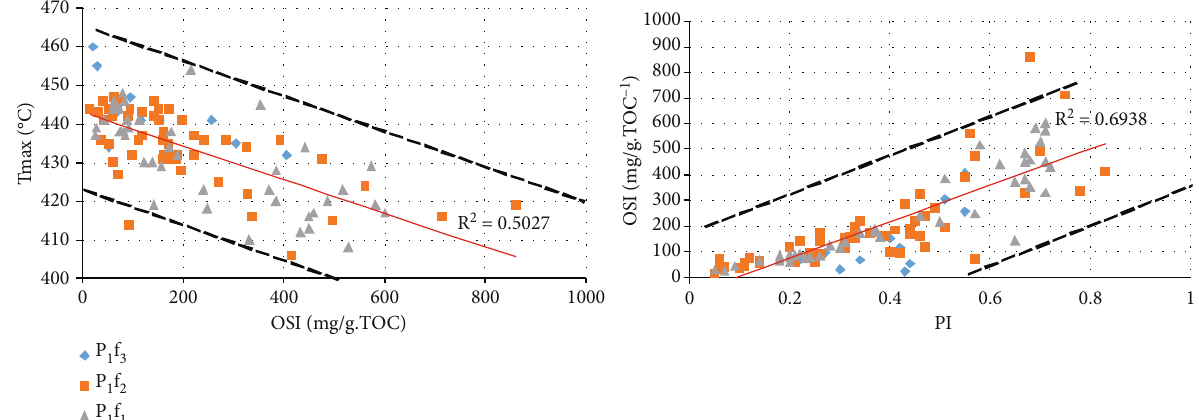
Figure 8: Variation of maturity with oil-bearing properties of the Fengcheng Formation shale and correlation between productivity and oil saturation indices (OSI).